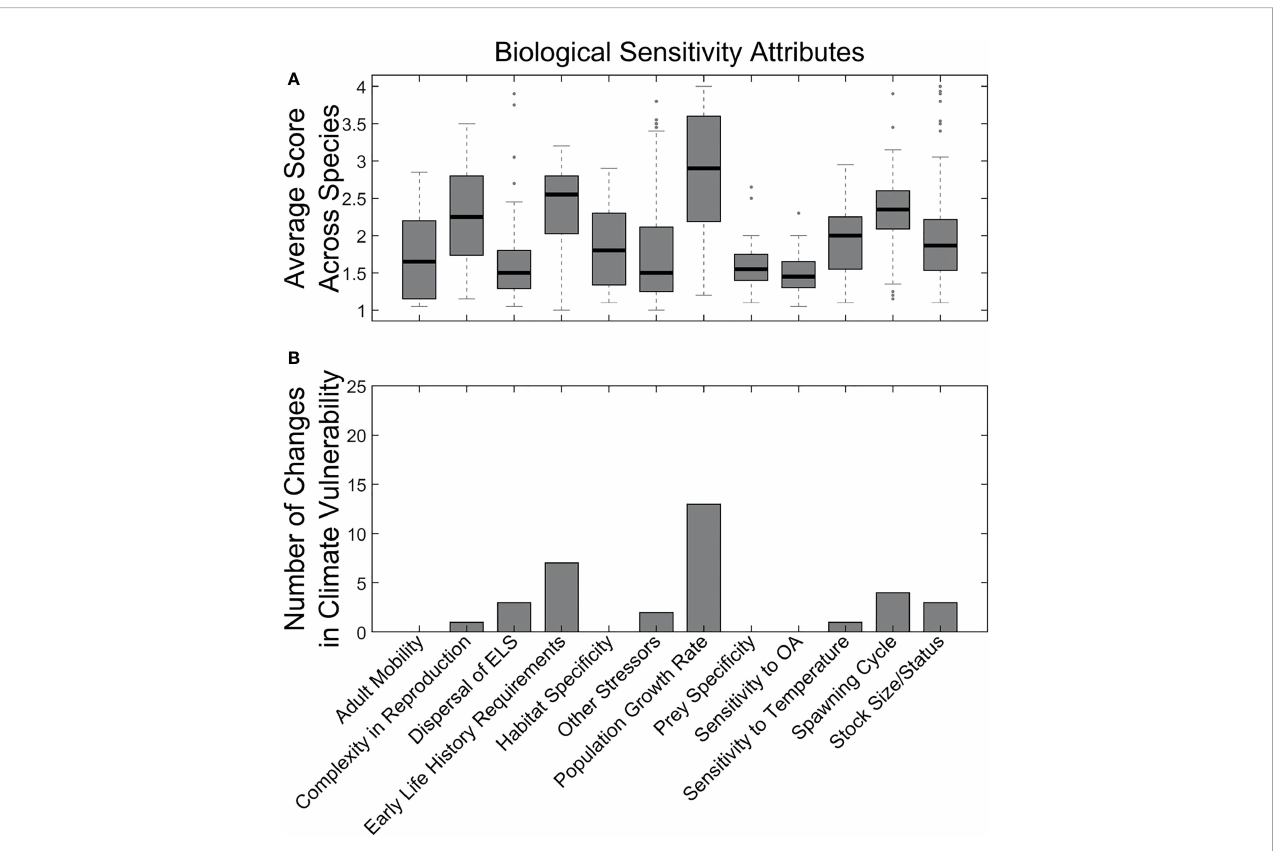
FIGURE 5 Average sensitivity attribute scores across all species (A) and results of sensitivity analysis (i.e., removing the attribute) for the effect of individual sensitivity attributes on overall climate vulnerability scores (B) . Methods follow those in Morrison et al.